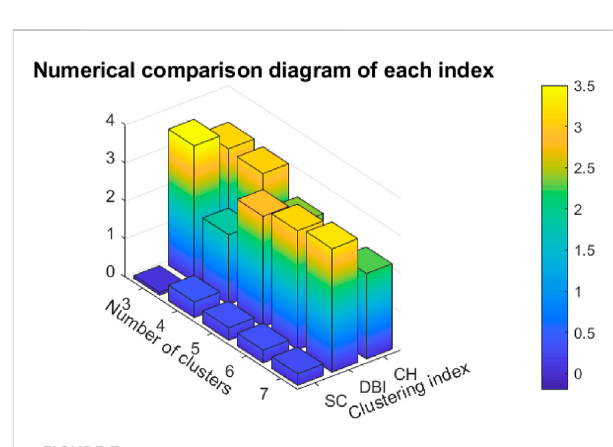
FIGURE 7 Comparison diagram of each cluster